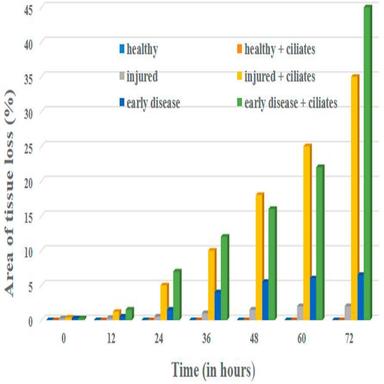
Tissue loss of Porties sp. inoculated with and without ciliates. Artificially injured and early disease sign Porites without ciliates was observed for minimal level of tissue loss. The ciliates inoculated early disease sign and injured Porites were observed for the high percentage of tissue loss under increased time series. No tissue loss were observed in only healthy and healthy inoculated with ciliates.